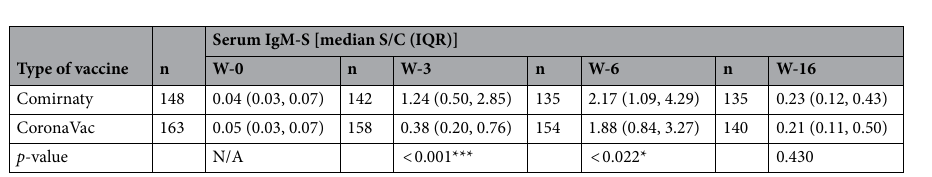
Table 5. Serum IgM-S antibody titers over time, based on the vaccine recipients. Samples (n), Signal/cutoff (S/C), and interquartile ranges (IQRs) indicate the minimum and maximum values. W-0, Week zero; W-3, Week three; W-6, Week six, W-16, Week 16. p value was set according to the Mann–Whitney U test. * p < 0.05; ** p < 0.01; *** p <